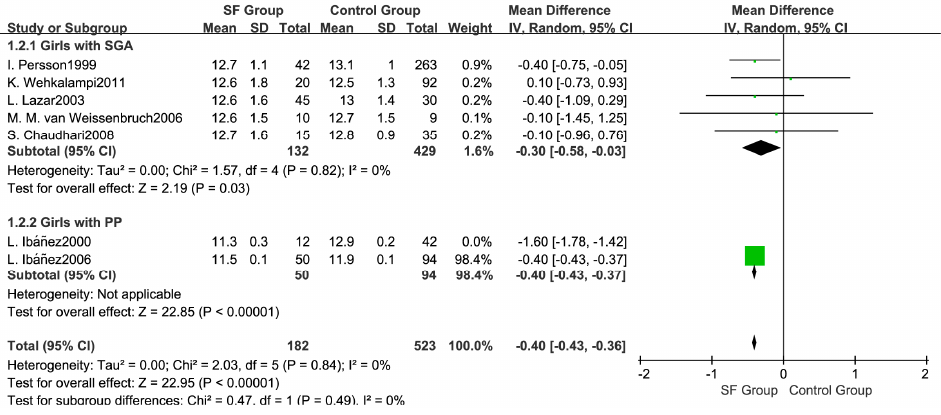
Figure 8. Sensitivity analysis for the age at menarche.